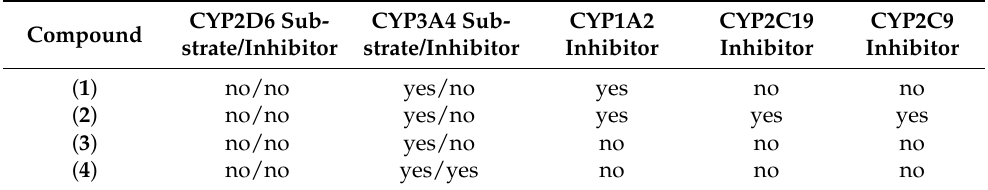
Table 6. The inhibitor/substrate features of natural compounds at CYP2D6, CYP3A4, CYP1A2, CYP2C19, and CYP2C9.